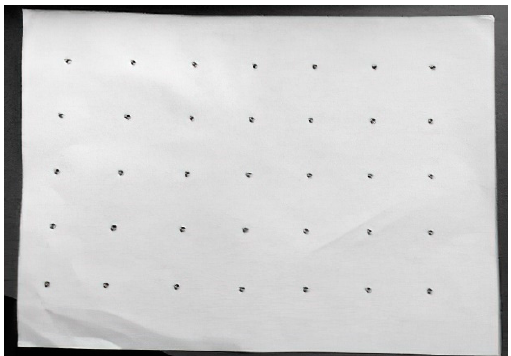
Figure 2. View of a pattern in the form of board of dots, printed on sheet of paper with IR ink, from an IR camera [9].